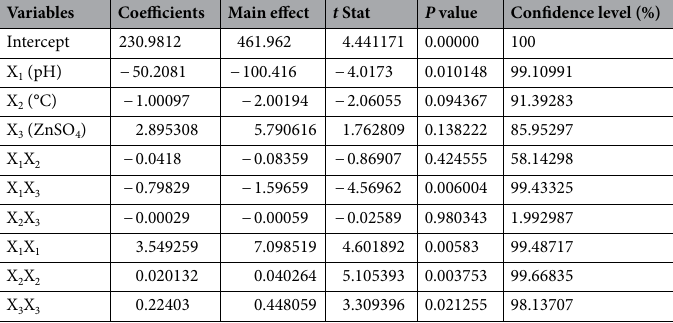
Table 3. Regression analysis for optimizing ZnO nanoparticles size using Box–Behnken design.